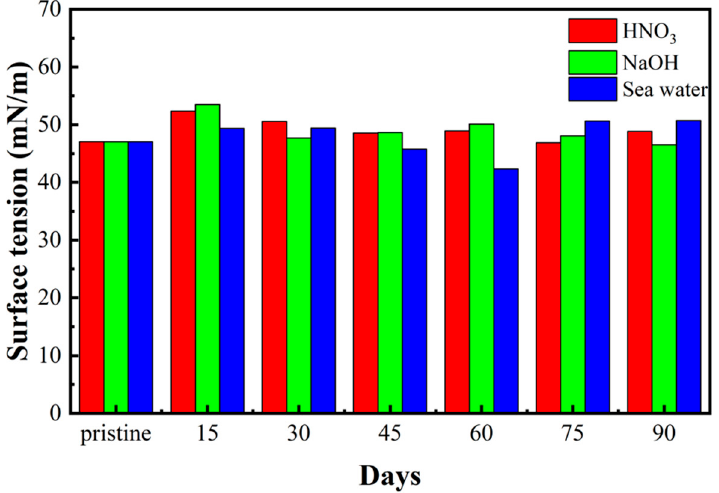
Figure 5. Surface tension of printed materials in different extreme environments after three months.